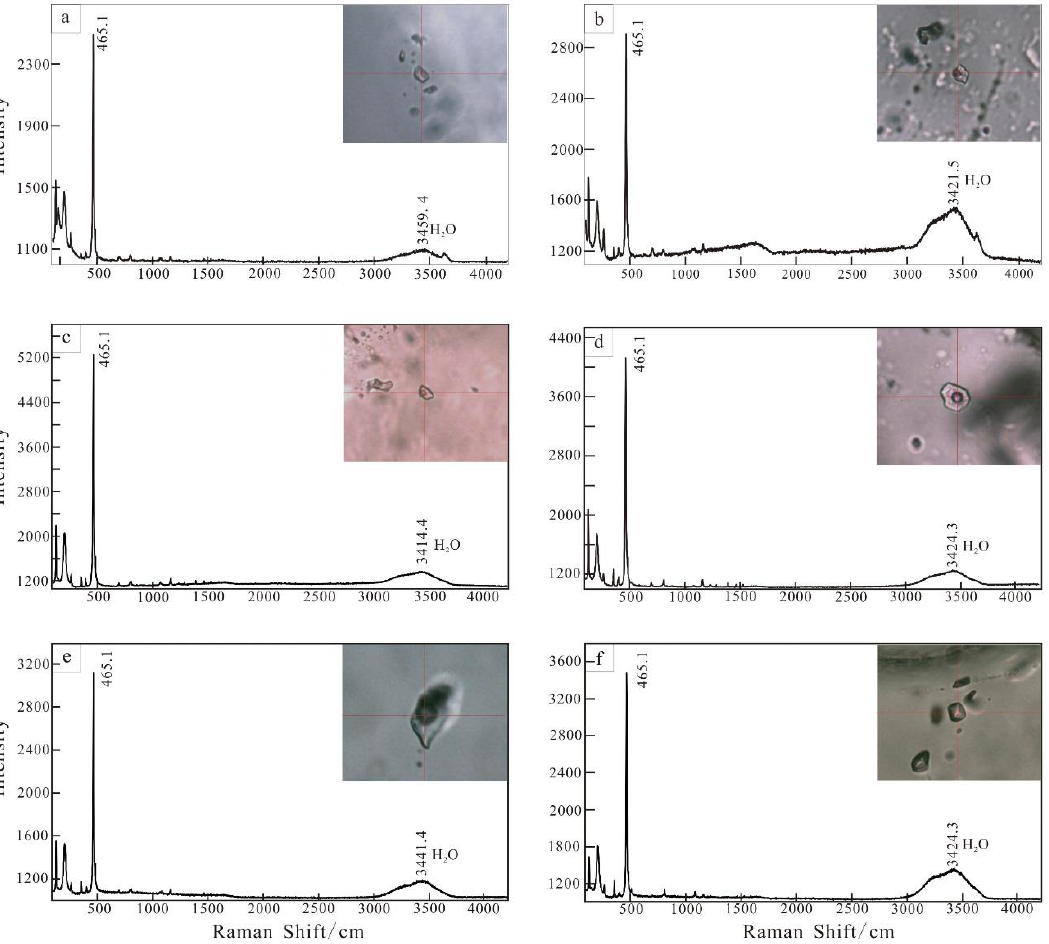
Figure 10. Laser Raman analyses of representative FIs from the Changkeng–Fuwan Au ( a , c , e )-Ag deposit ( b , d , f ).